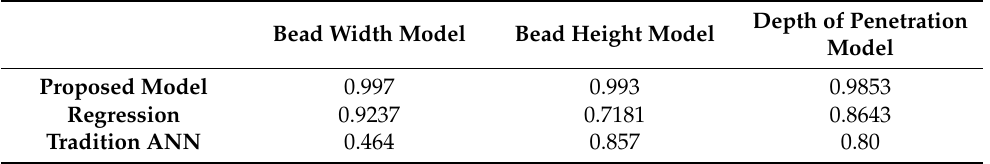
Table 4. Statistical measures of the proposed model, regression, and ANN classification